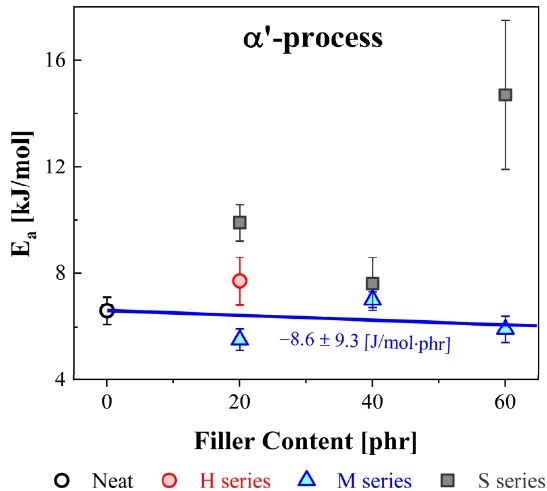
Figure 11. Comparison of activation energy with the different filler loading contents and types. The blue solid lines represent the linear fitting results for the M series.